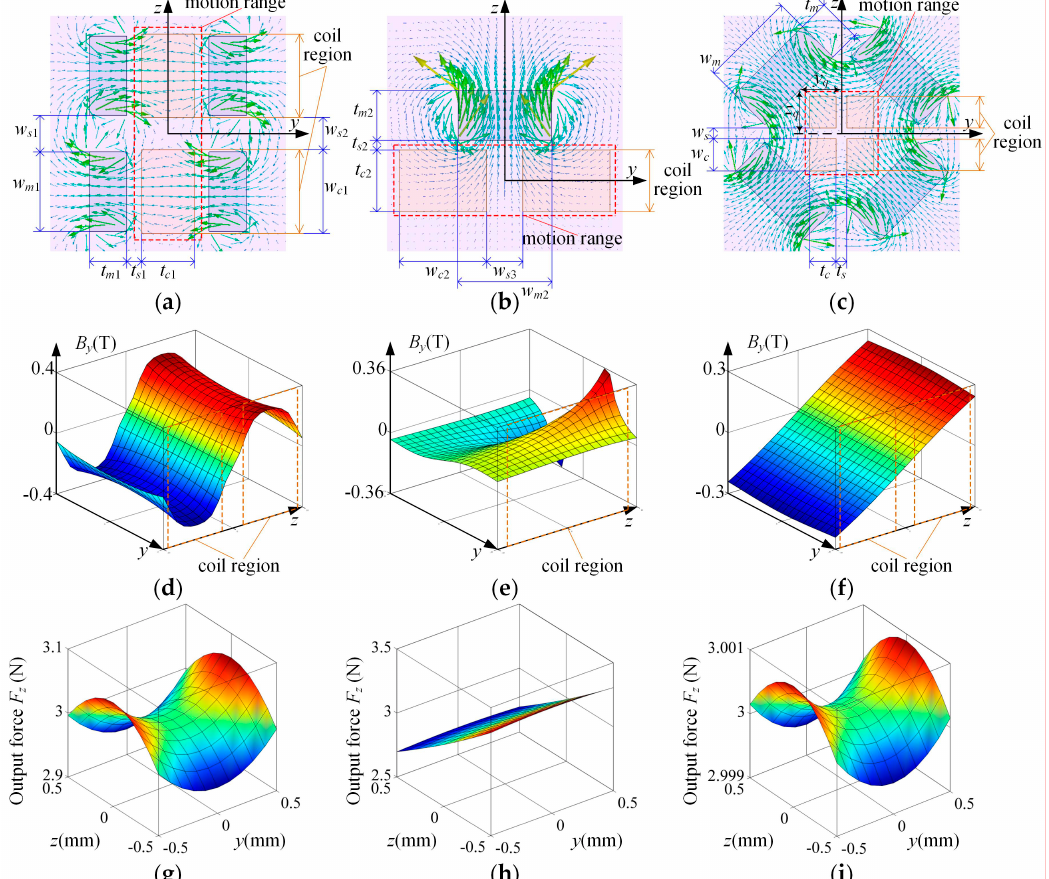
Figure 2. Structure of the conventional VCAs. ( a ) Structure of the FR-VCA. ( b ) Structure of the OR-VCA. ( c ) Structure of the OS-VCA. ( d ) Structure of the OC-VCA.